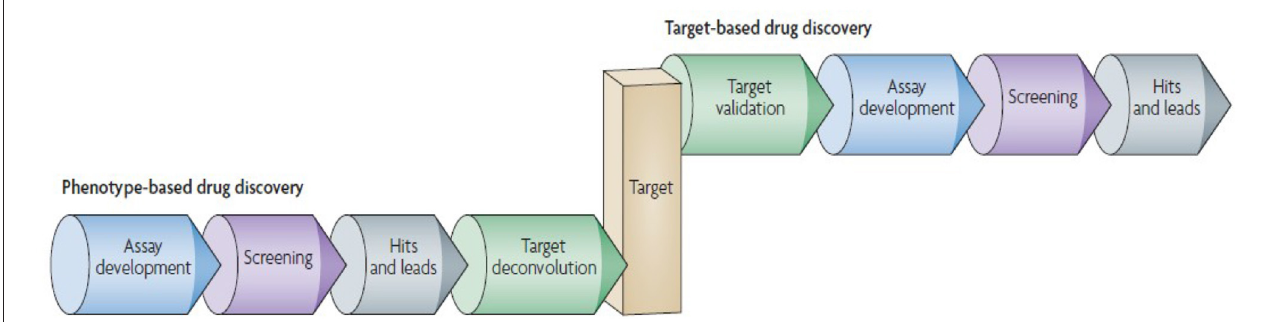
FIGURE 4 | Phenotype-based vs. target-based drug discovery. The figure demonstrates the identification of molecular target and lead molecules during early phase drug discovery process. The phenotype-based approach first obtains lead molecules, and then proceeds with target deconvolution for identifying the targets that highlights observed phenotypic effects. In target-based approach identification and validation of molecular targets takes place before starting the actual lead discovery (Reprinted by permission from Macmillan Publishers, Ltd.: Nature Reviews Drug Discovery , ref. [109], copyright